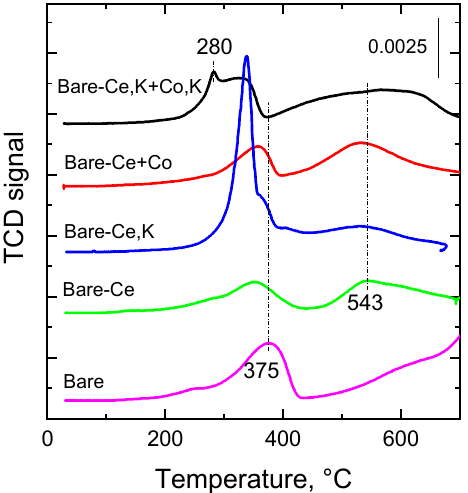
Figure 3. H 2 -TPR of the examined catalysts.